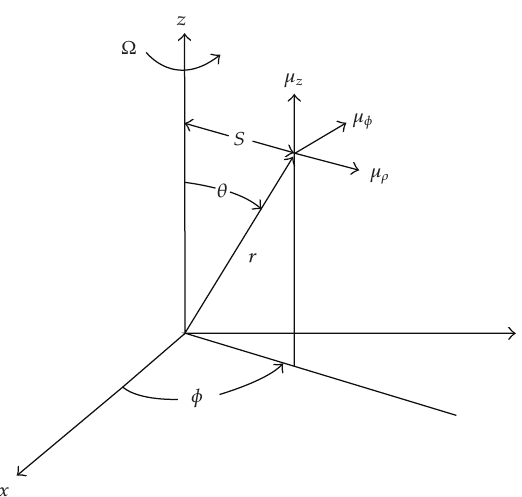
Figure 1: Sketch of the spin and dipole coordinates from Harrison and Tademaru (cid:4) 2 (cid:5)